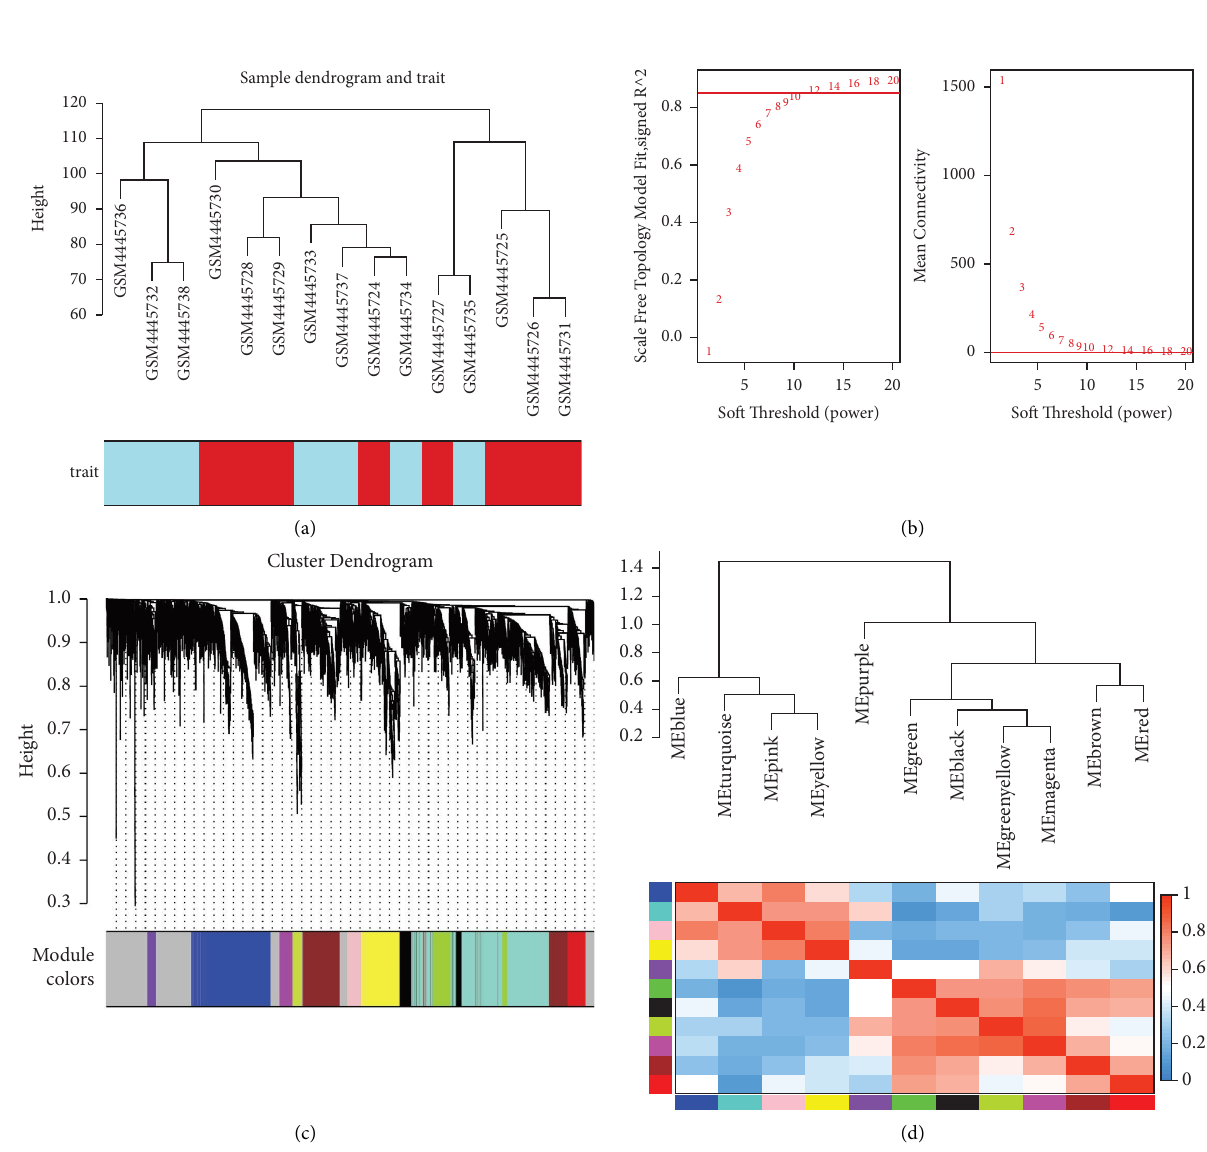
Figure 2: WGCNA of dataset GSE147776. (a) Cluster dendrogram of samples. (b) Determination of soft threshold power. (c) Clustering dendrogram of the top 5000 genes with the median absolute deviation value in GSE147776. (d) Module eigengene adjacency